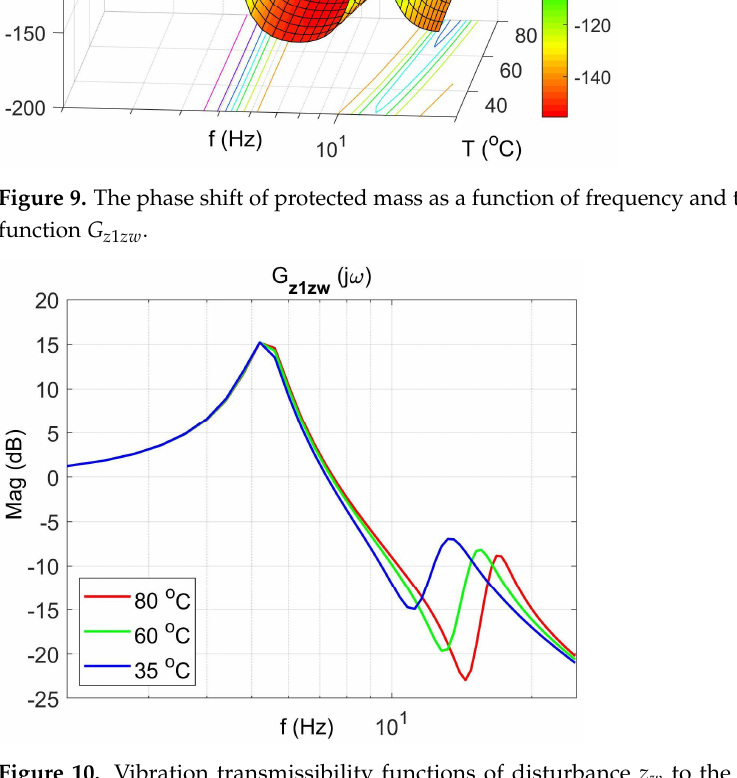
Figure 10. Vibration transmissibility functions of disturbance z w to the protected mass m 1 as a function of frequency for selected temperatures 25 ◦ C, 60 ◦ C, 80 ◦ C, the transfer function G z 1 zw